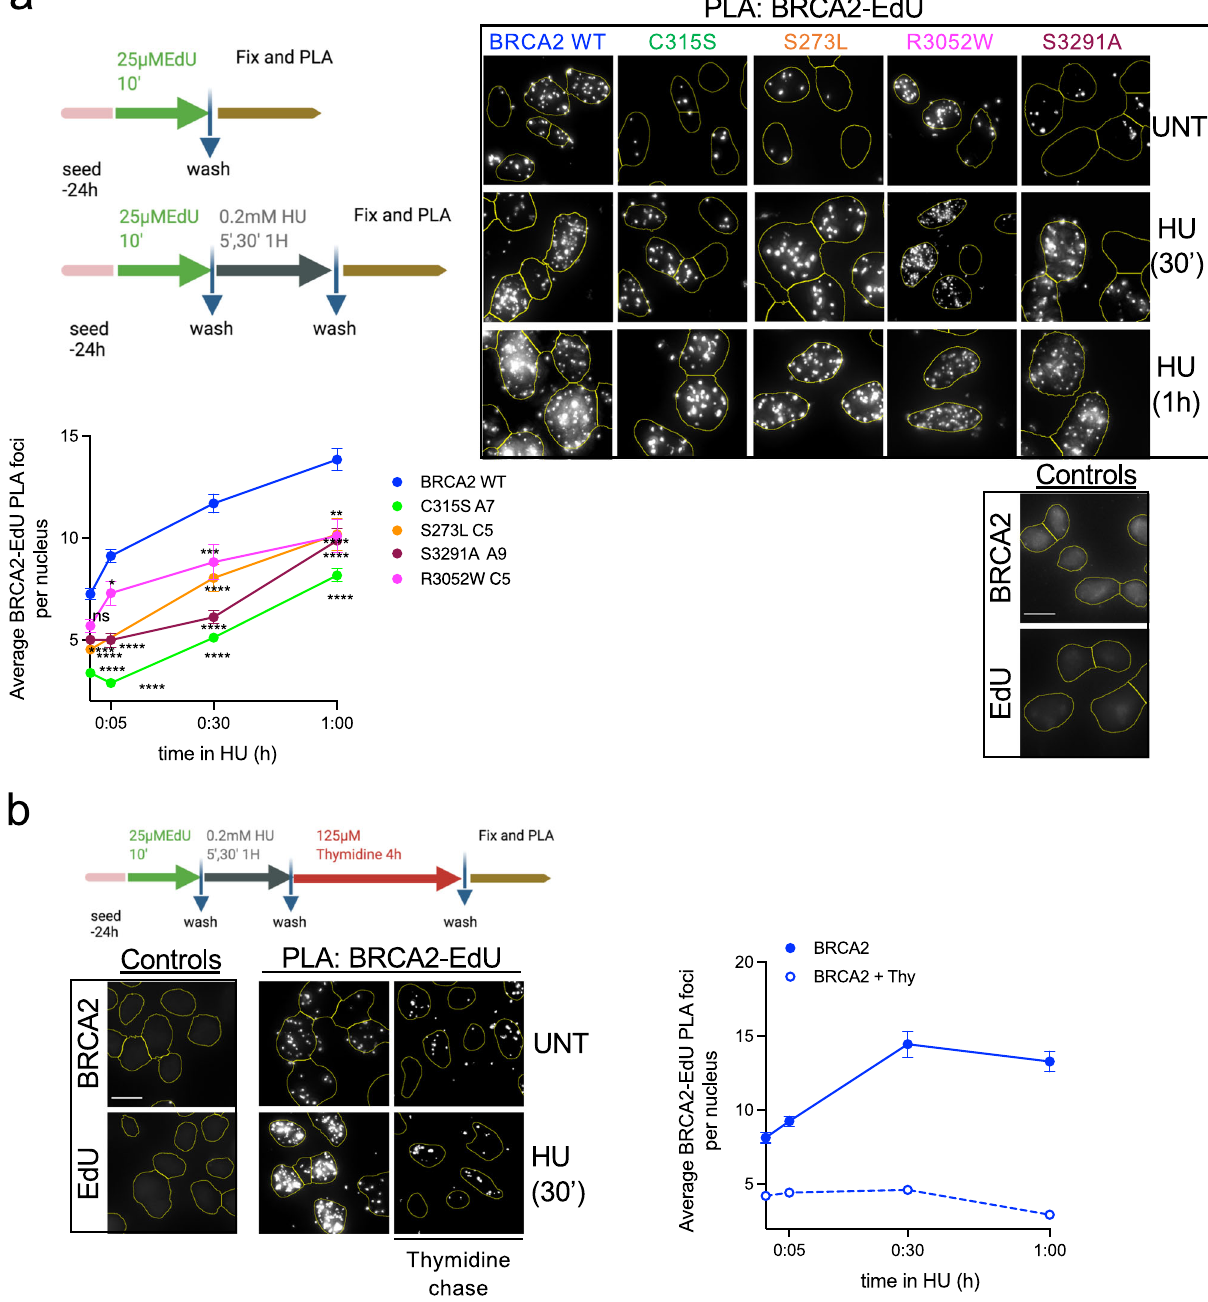
Fig. 2 | BRCA2 NTD and C-terminal domains contribute to BRCA2 location at nascentDNA.a (Top left)Scheme ofthe assay. (Top right):Representative images of in situ PLA on nascent DNA between biotinylated EdU detected with anti-biotin antibody and BRCA2-speci fi c antibody in DLD1 BRCA2-de fi cient cells (BRCA2 − / − ) stablyexpressingeitherBRCA2WTorthevariantsC315S(A7),S273L(C5),R3052W, andS3291Amutant,asindicated.Cellsleftuntreated(UNT)ortreatedwithHU(30 ′ or1h0.2mM)areshown.Anindividualsignalisobserved(focus)ifthetwoprobed proteins (BRCA2 and EdU-Biotin) are in close proximity (<40nm). For all the experiments we carried out two single-antibody control (anti-BRCA2 and anti- biotin) to assess the speci fi city of the PLA signal. The scale bar indicates 10 μ m. (Bottom)Quanti fi cationoftheBRCA2recruitmentwasmeasuredasthenumberof PLA foci observed per nucleus. The data represent the mean+SEM with 200 – 300 cells analyzed in each experimental data set at each time point. The number of independent experiments performed was as follows: BRCA2 WT: (UNT n =10; 5 ′ n =5;30 ′ n =8;1h n =7),C315S: (UNT n =6; 5 ′ n =3; 30 ′ n =5;1h n =5);S273L:(UNT n =4; 30 ′ n =2; 1h n =2); S3291A: (UNT n =3; 5 ′ n =2; 30 ′ n =2; 1h n =2); R3052W: